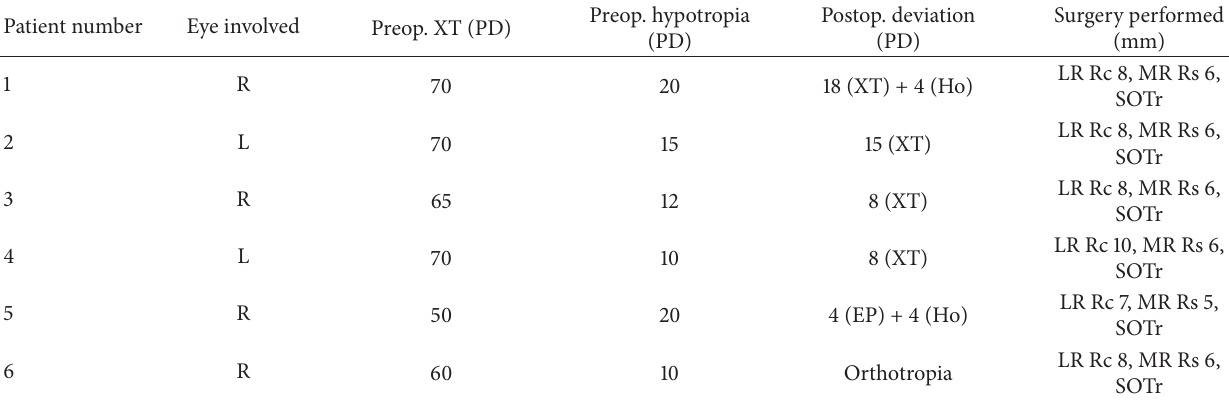
Table 2: Preoperative and postoperative deviations and surgeries